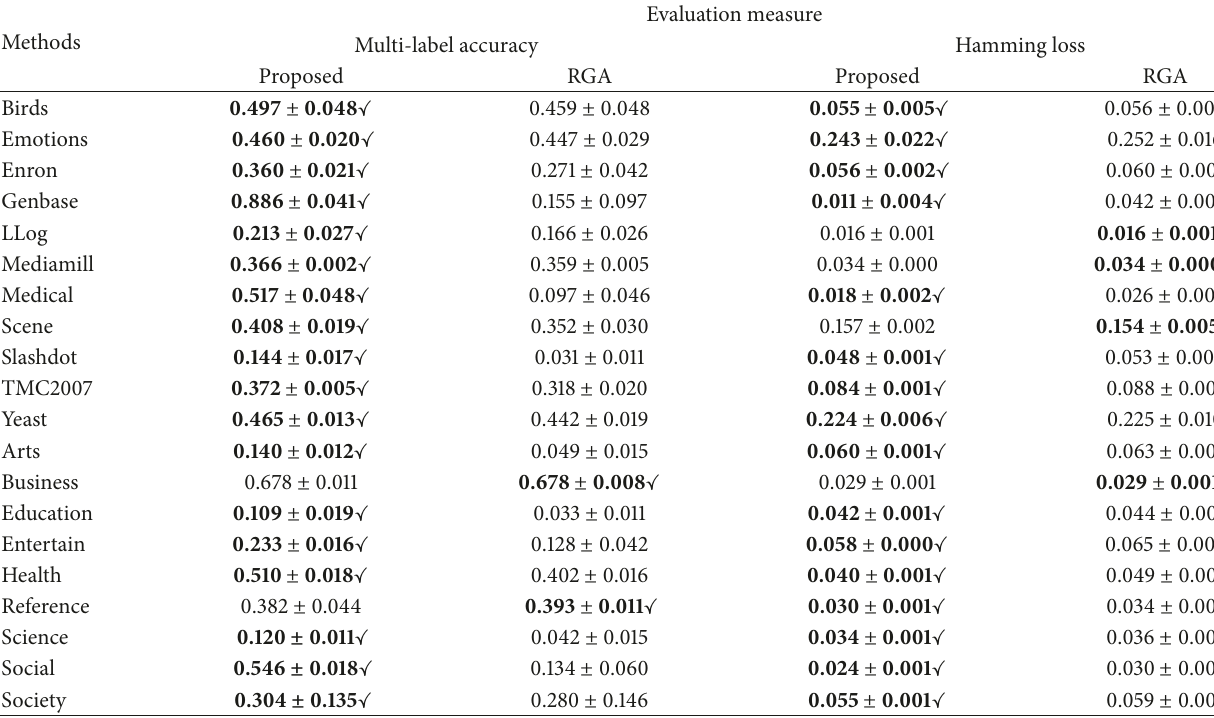
Table 3: Comparison results for multilabel feature selection methods in terms of multilabel accuracy and Hamming loss (mean ± std. deviation). The ✓ symbol indicates the method that achieves the best performance for each dataset.